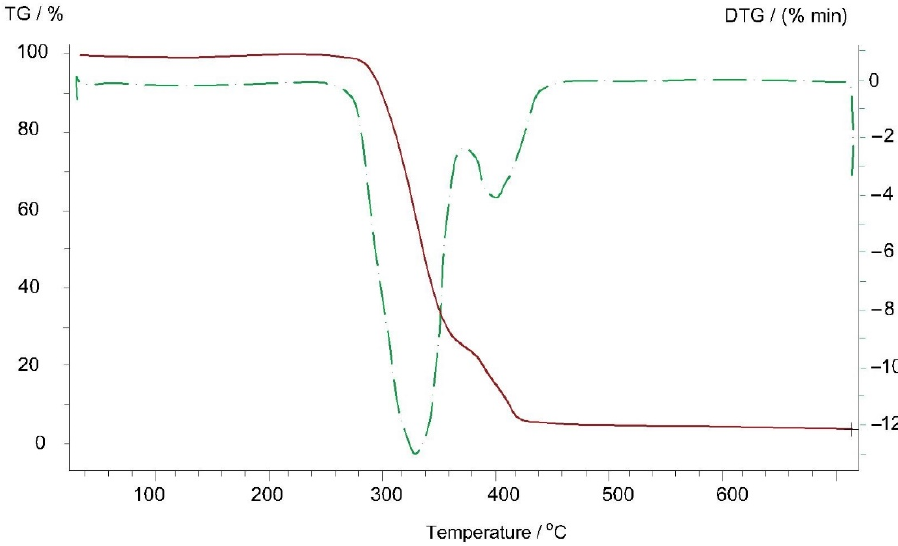
Figure 10. Thermogravimetric curve of the Arboblend ® V2 Nature sample. Arbofill ® Fichte , Figure 9: In the 89–139 ◦ C temperature range, there is a first mass loss at a small percentage of only 1.33%, which can be associated with the beginning of water evaporation from the basic matrix of the material (lignin, natural fibers): - The second mass loss at a percentage of 20.23%, in the 267–377 ◦ C temperature range, coincides with the endothermic transformation that reaches the maximum phase at the temperature of 368 ◦ C (T max from DTG) and which is associated with the decomposition of a material constituent element, possible natural vegetable fibers or an additive/resin